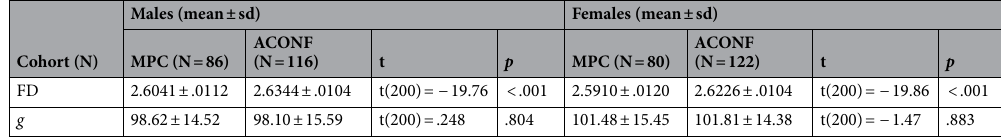
Table 7. Sex-differences in complexity (FD) and general inteligence g between MPC (Indian cohort) and ACONF (an UK cohort); with t statistic and the probability p < .05, mentioned in the table.